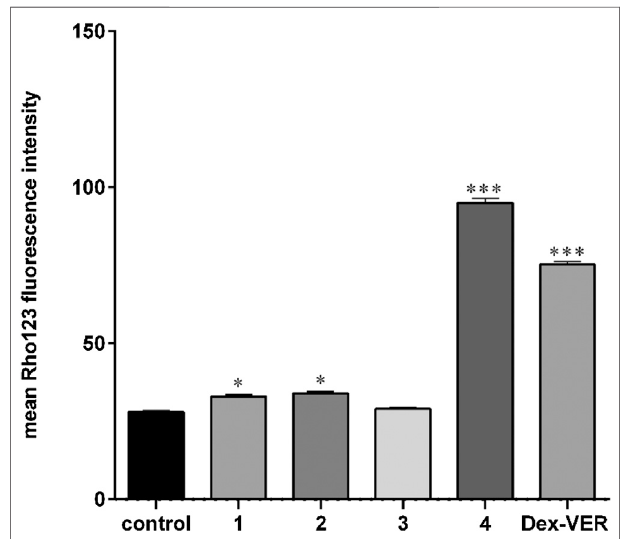
FIGURE 3 | Royleanone derivatives increase the Rhodamine 123 accumulation implying anti-P-gp activity. Experiments were performed in triplicates(n (cid:1) 3).Signi fi cantdifference compared tocontrol:* p < 0.05,***p < 0.001.